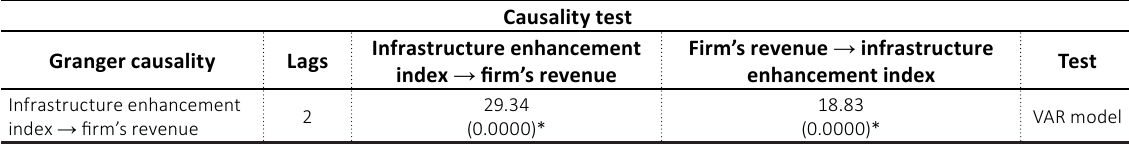
Source: Own edition and calculations